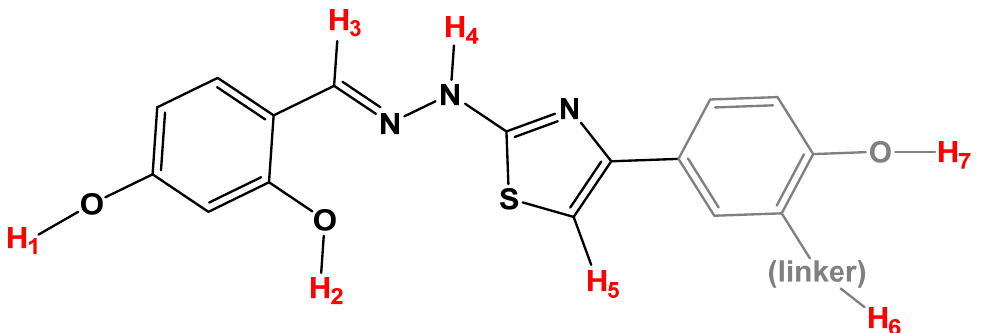
Figure 5. General structure of the compounds and the possible sites which can release hydrogen atoms to neutralize radicals numbered H 1 –H 7 . Table 9. The computed BDE for the hydrogen atoms from the studied compounds (kcal/mol).